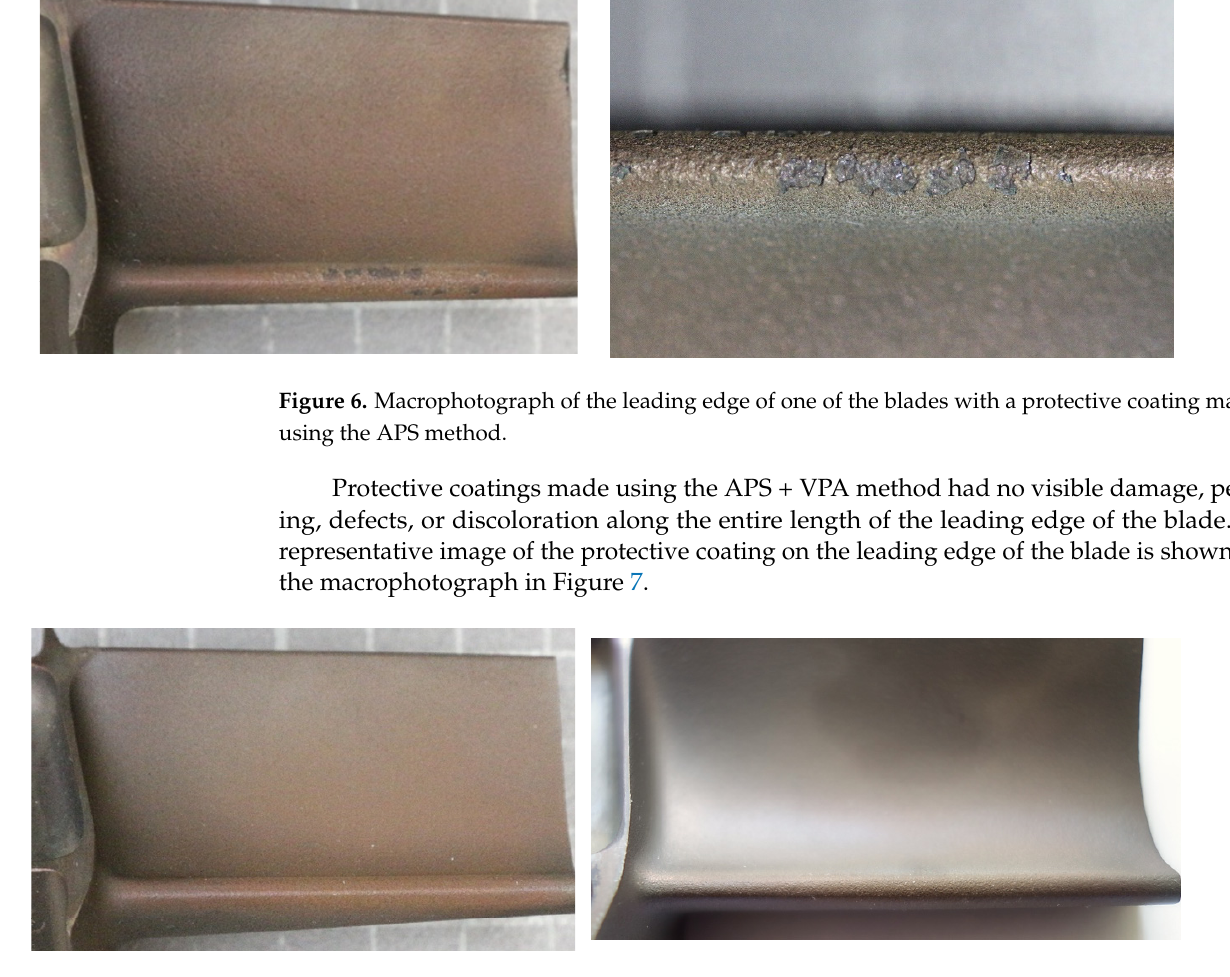
Figure 7. Macrophotographs of the leading edge of blades with a protective coating made by the APS + VPA method.